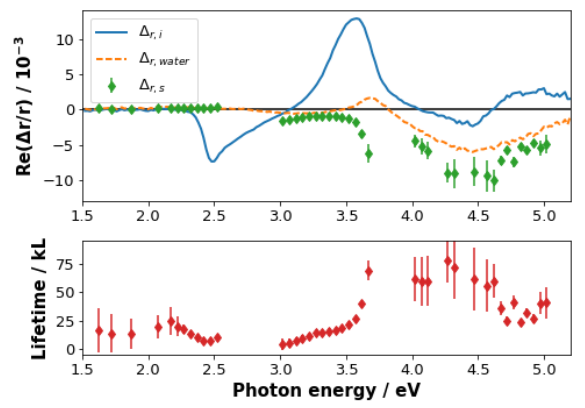
Figure 5: Initial RA spectrum of the P-rich surface (blue) together with the spectrum after 58 kL of water (orange, dashed) and the saturation values from the fits (green). The lower part of the plot shows the corresponding lifetimes. Values with large errors as well as negative τ were